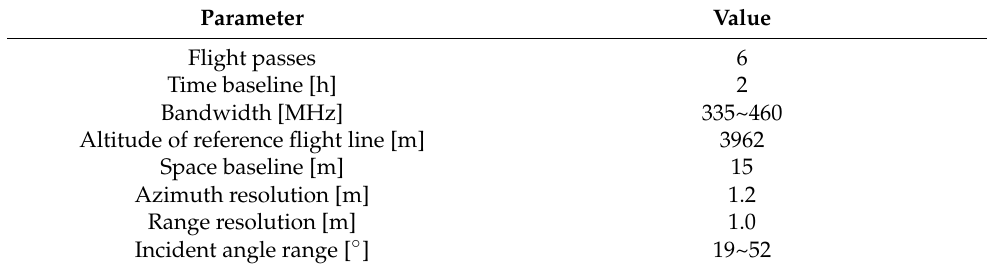
Table 1. Parameters of SAR dataset.